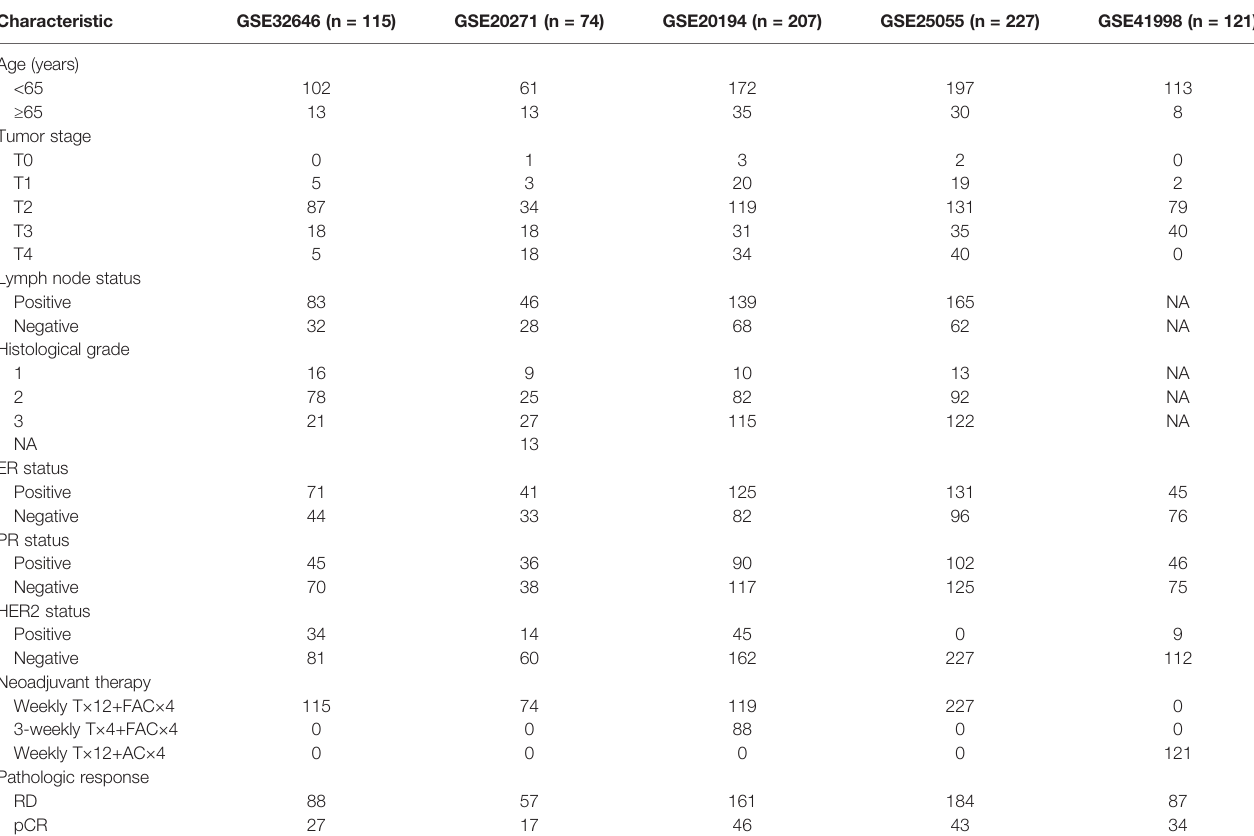
TABLE 1 | Clinical characteristics of